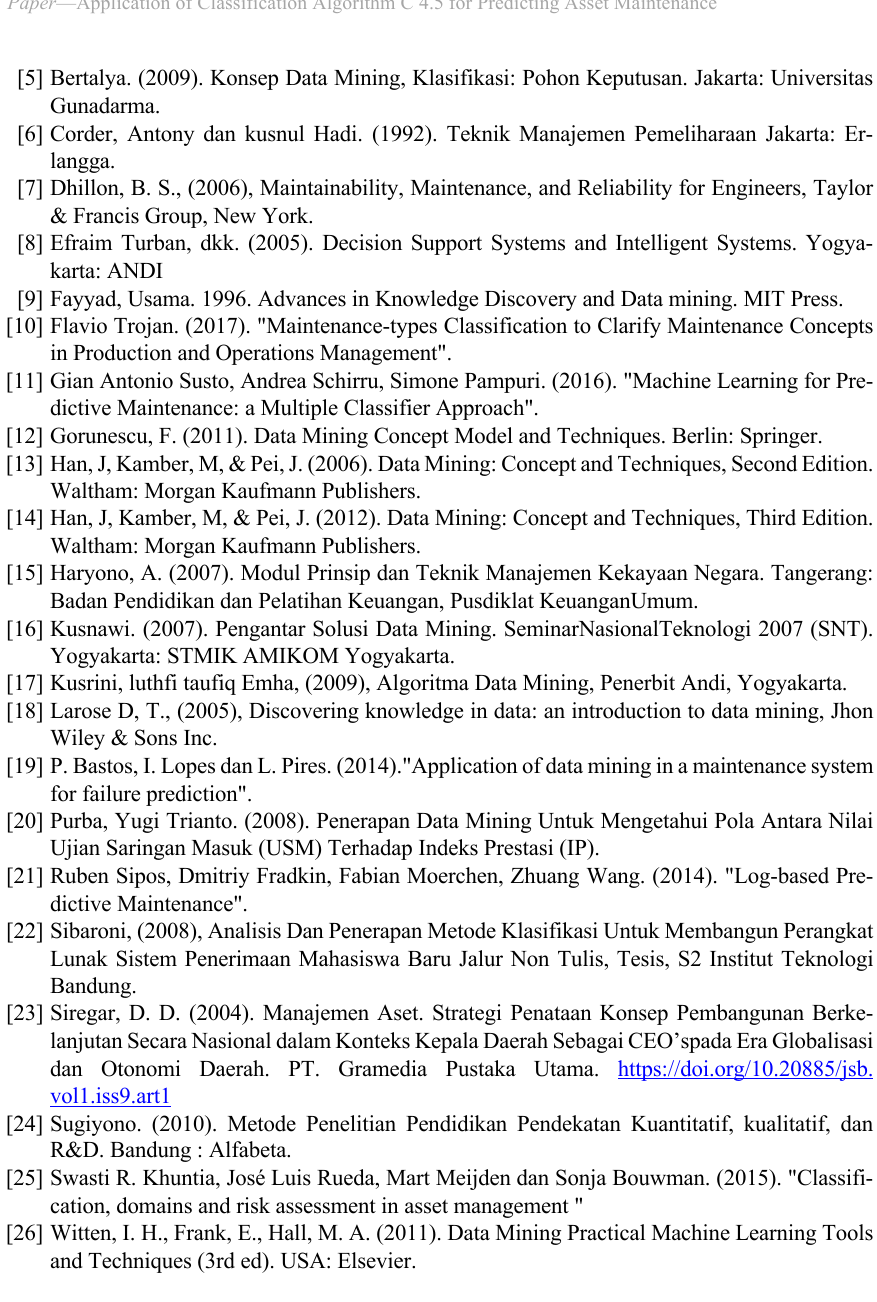
Paper —Application of Classification Algorithm C 4.5 for Predicting Asset